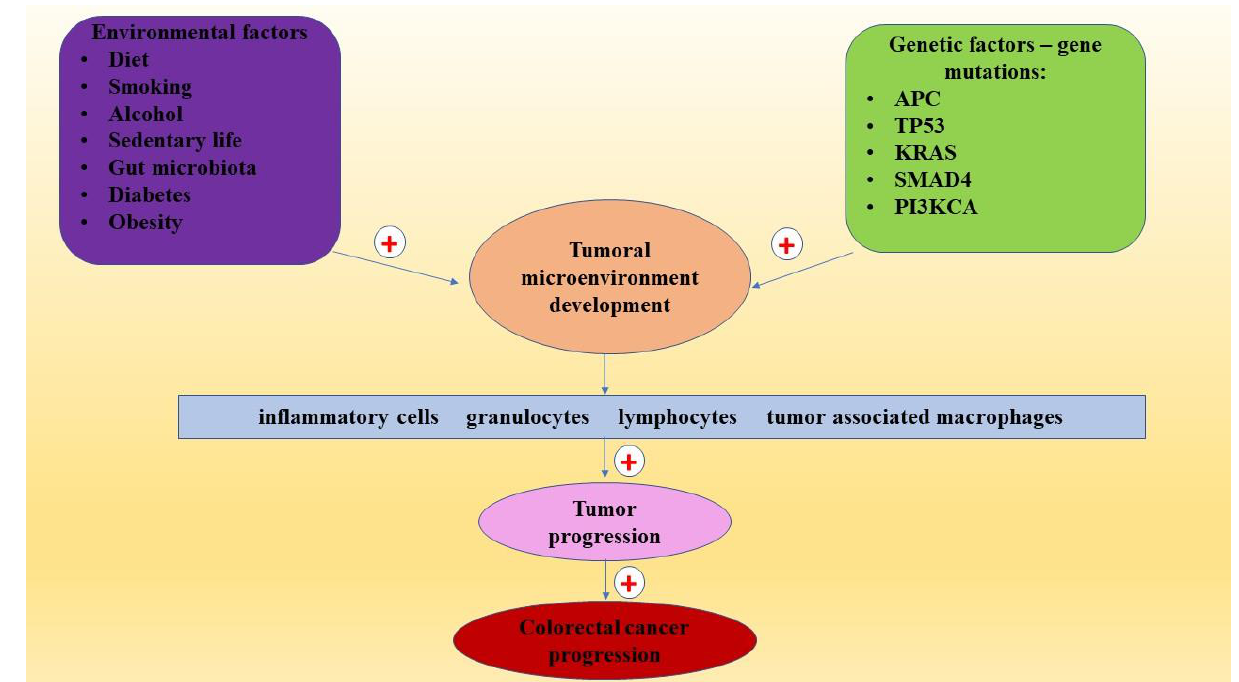
Figure 1. The environmental and genetic factors involved in colorectal cancer progression.